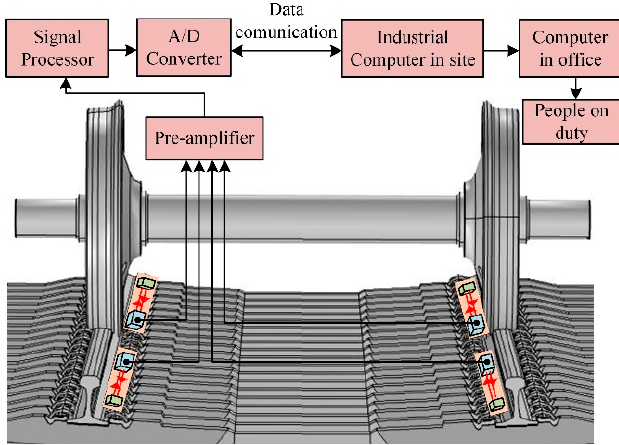
Figure 4. The schematic diagram of laser collimation measurement system.